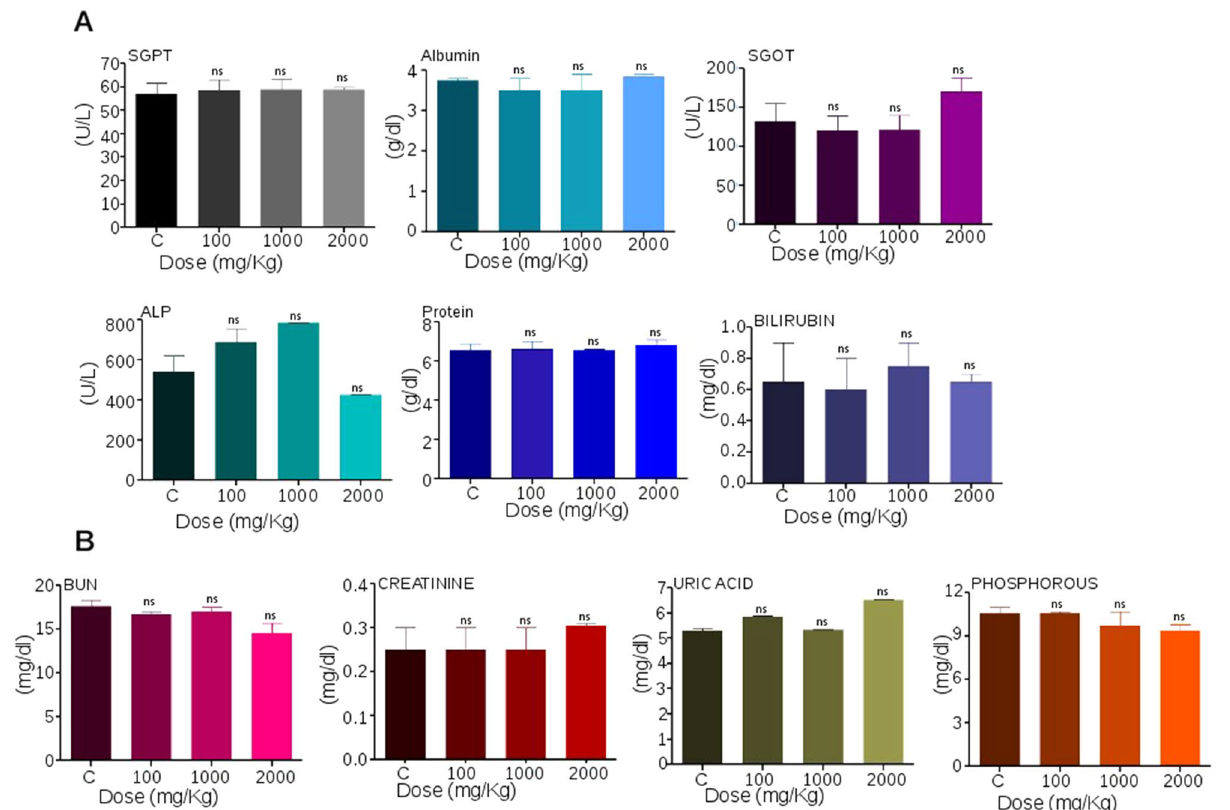
Figure 6. Analysis of liver and kidney function following treatment with Disarib in rats. ( A ) Analysis of serum parameters for liver function among control and different Disarib treated rats (100, 1000, 2000 mg/kg b. wt.) after 14 days of dose administration. SGPT serum glutamic pyruvic transaminase, SGOT serum glutamic- oxaloacetic transaminase, ALP alkaline phosphatase. ( B ) Analysis of serum parameters for kidney function among control and different doses of Disarib (100, 1000, 2000 mg/kg b. wt.) after 14 days of dose administration. BUN Blood urea nitrogen. Error bars denote mean + SEM ( ns not